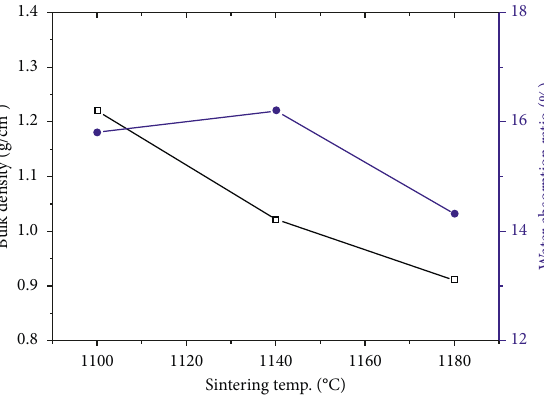
Figure 5: Physical properties of the lightweight aggregate by rapid sintering.